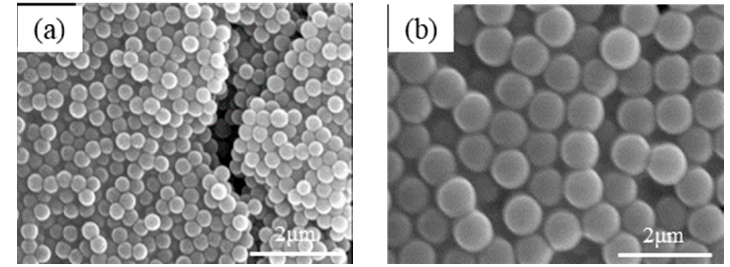
Figure 2. SEM images of enlarged SiO 2 nanoparticles prepared using increased NH 3(aq) concentrations of: ( a ) 0.63 M and ( b ) 2.0 M.